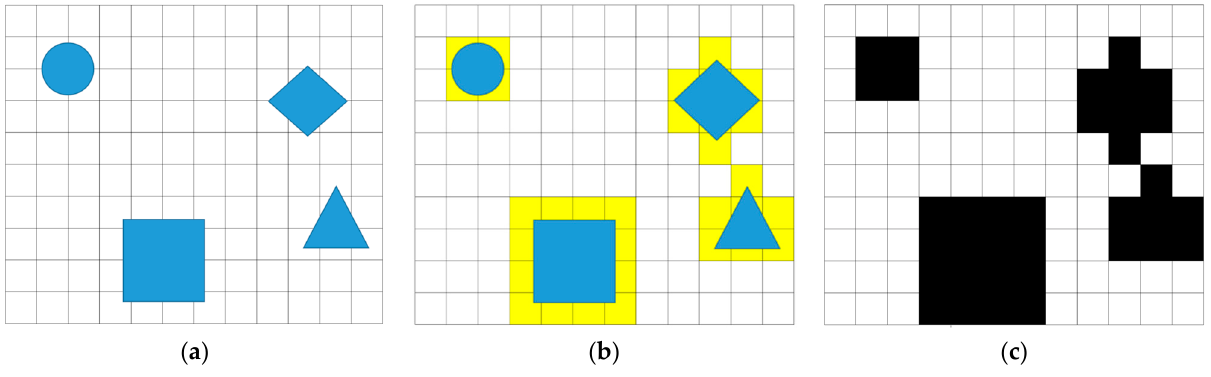
Figure 5. The occupancy 2D grid map of the real environment. ( a ) Environmental grid map with real obstacles and cells; ( b ) occupied cells related to the real obstacles; ( c ) virtual 2D grid map with black occupancy cells.